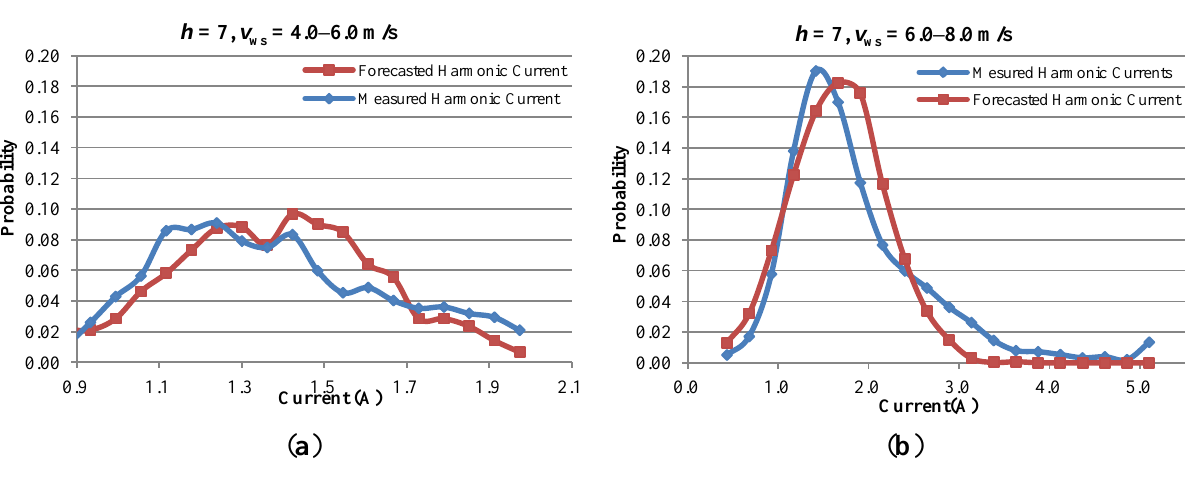
Figure 11. Measured and forecasted probability distributions of the 11th harmonic